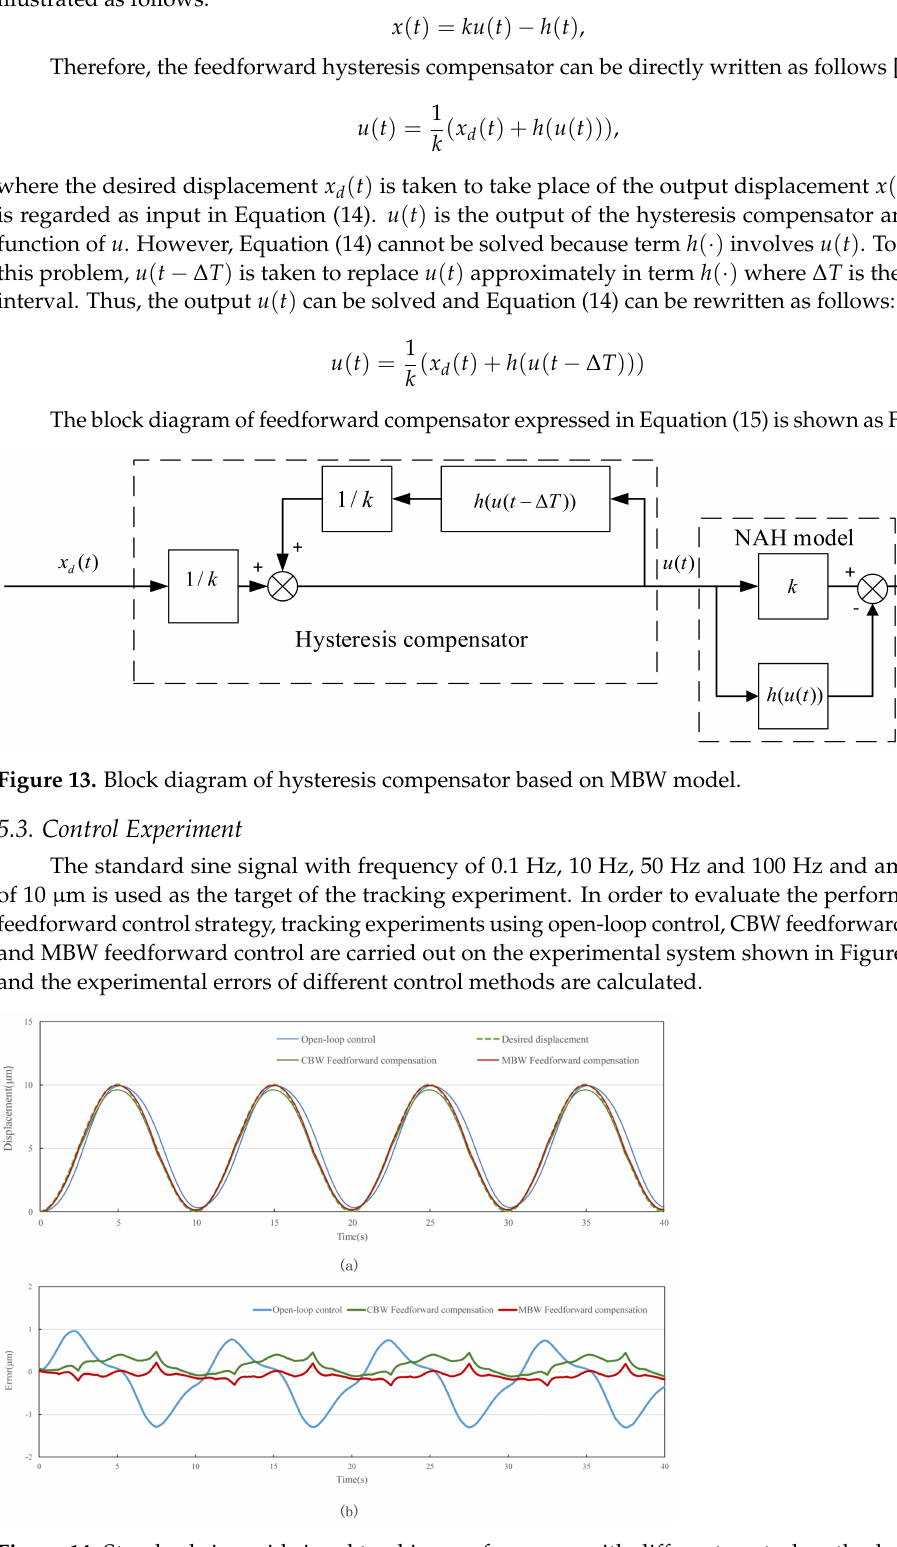
Figure 14. Standard sinusoid signal tracking performance with different control method at 0.1 Hz. ( a ) tracking displacement. ( b ) error